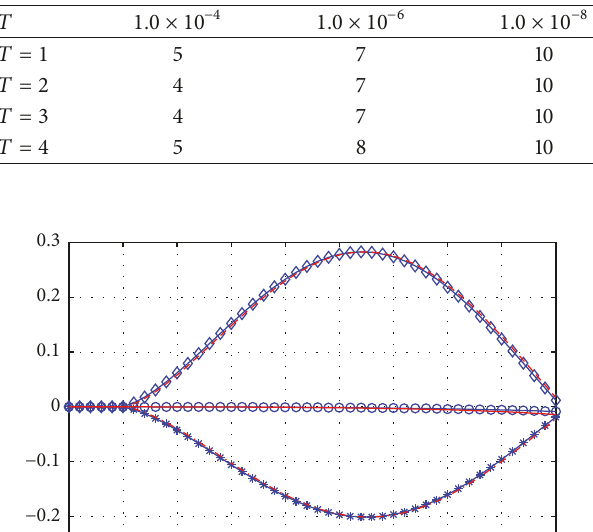
Table 2: Between the iteration allowable error and the number of iterations.